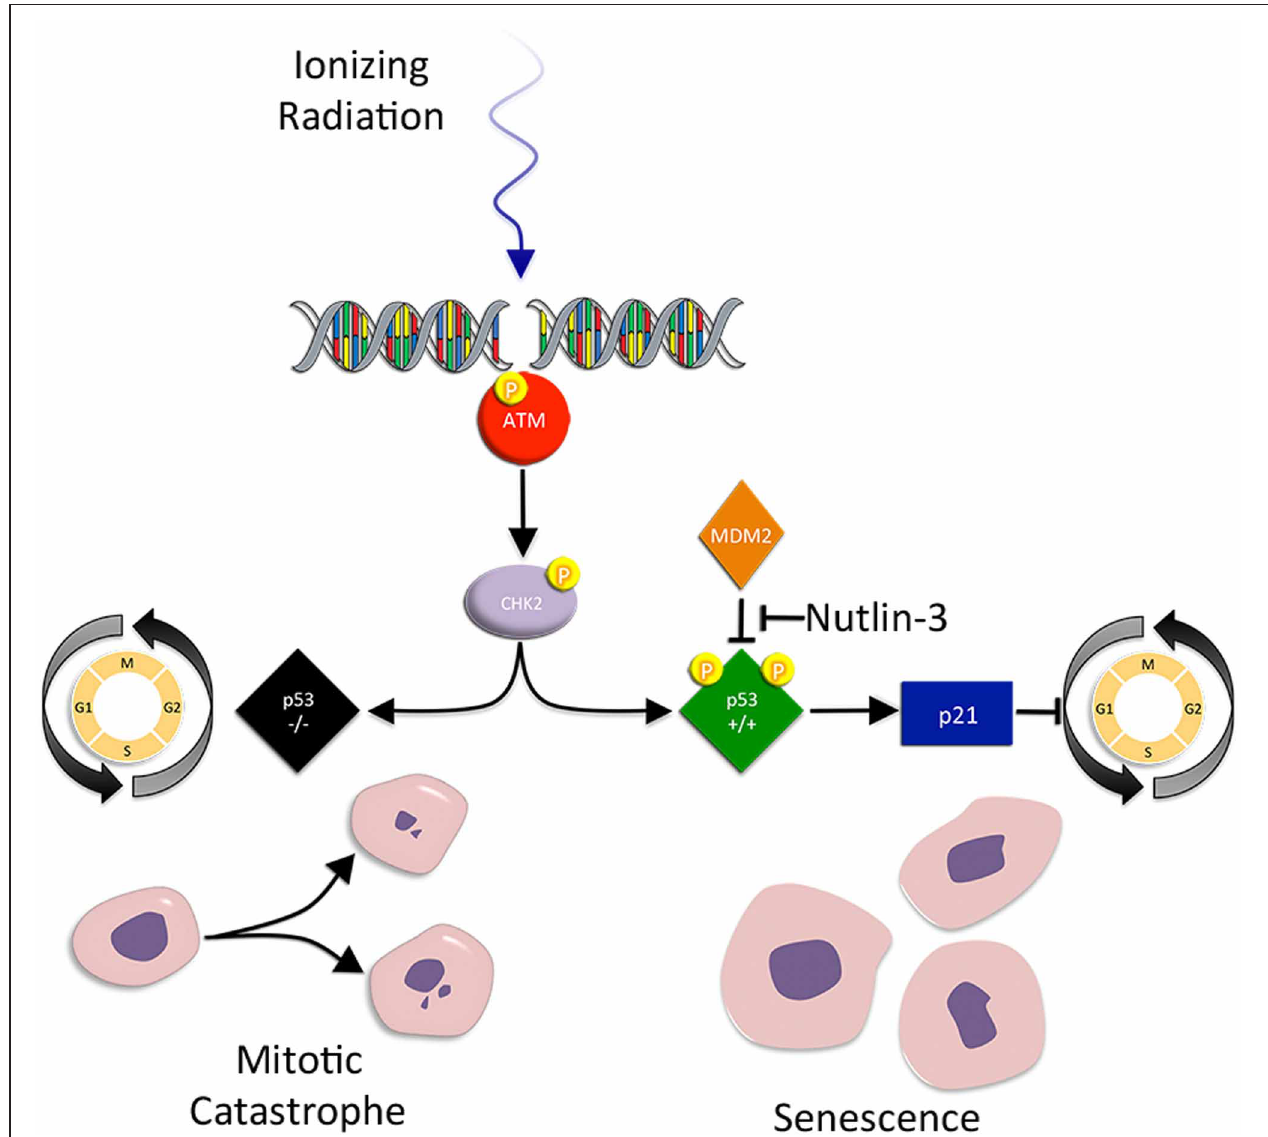
FIGURE 2 | Mitotic catastrophe and senescence. Mitotic catastrophe (MC) occurs after failed mitosis. Cells are characterized by an increased frequency of multiple nuclei and micronuclei. Checkpoint control is greatly reduced in mutant p53 tumor cells, making the cells susceptible to premature mitosis, chromosomal dysegregation, the generation of aneuploid progeny, and MC associated cell death. Senescence on the other hand, is a form of irreversible